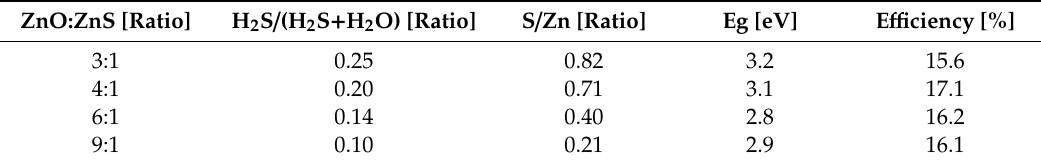
Figure 3. Efficiency and energy bandgap (Eg) of CIGSSe solar cell depending on the Zn(O,S) ratio. Table 1. Properties of Zn(O,S) films deposited with 100-cycle on